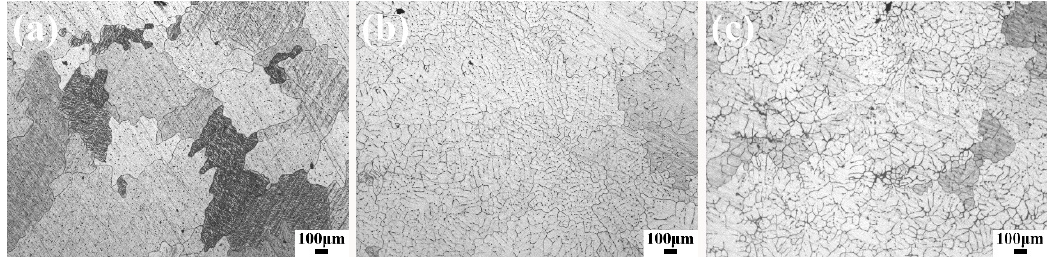
Figure 1. The optical microscope (OM) observations of as-cast alloys: ( a ) Mg-0.5 wt.% Sr, ( b ) Mg-0.5 wt.% Sr-1 wt.% Mn, ( c ) Mg-0.5 wt.% Sr-2 wt.% Mn.